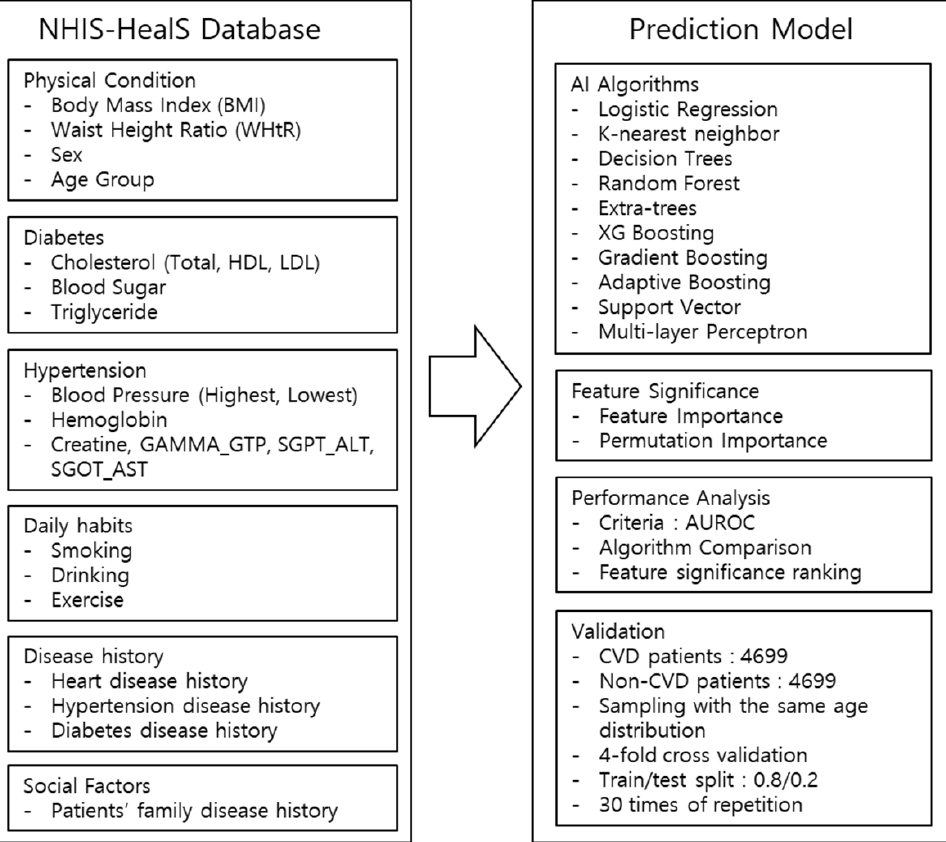
Figure 1. Study process and architecture of the CVD prediction model.